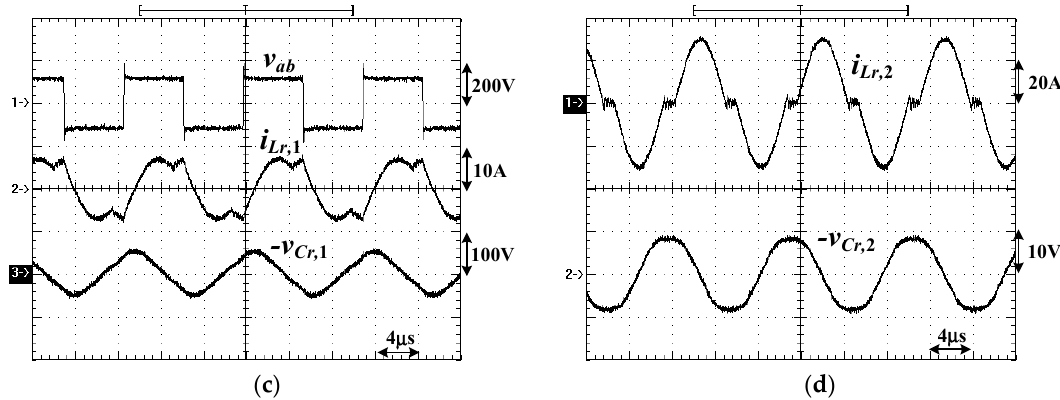
Figure 9. Measured results of the proposed converter under V in = 118 V, V o = 52 V, and I o = 7.8 A: ( a ) the gate voltages of S 1 – S 4 ; ( b ) v S 1, g , v S 1, ce , and i S 1 ; ( c ) v ab , i Lr, 1 , and – v Cr, 1 ; ( d ) i Lr, 2 and – v Cr, 2 . Figure 10 gives the test results of the converter under V in = 238 V and the maximum power conditions. The half-bridge resonant circuit and half-wave diode rectifier are used in the converter (Figure 1c) under V in = 238 V input. Only switches S 1 and S 2 are controlled on the left-hand side. Figure 10a gives the gate voltages and resonant current and voltage on the input side. The resonant current and voltage on the output side are provided in Figure 10b. The switch voltage and current of S 1 are provided in Figure 10c. The switching frequency of the converter at V in = 238 V input and full power condition is about 96 kHz, which is close to the resonant frequency (100 kHz). The resonant currents i Lr ,1 and i Lr ,2 are quasi-sinusoidal waveforms. Power switch S 1 is also turned on at zero-voltage switching under the V in = 238 V condition (Figure 10c).